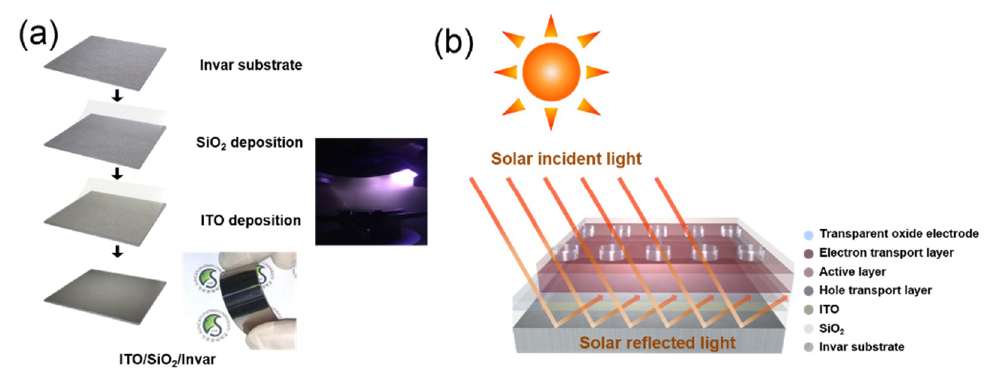
Figure 1. ( a ) Schematic fabrication process of flexible ITO films on SiO 2 coated invar metal substrate using typical DC magnetron sputtering at room temperature. The images show ITO sputtering process and curved invar substrate with ITO electrodes. ( b ) Device structure of curved perovskite solar cells with transparent InSnO anode and InZnSnO top cathode.